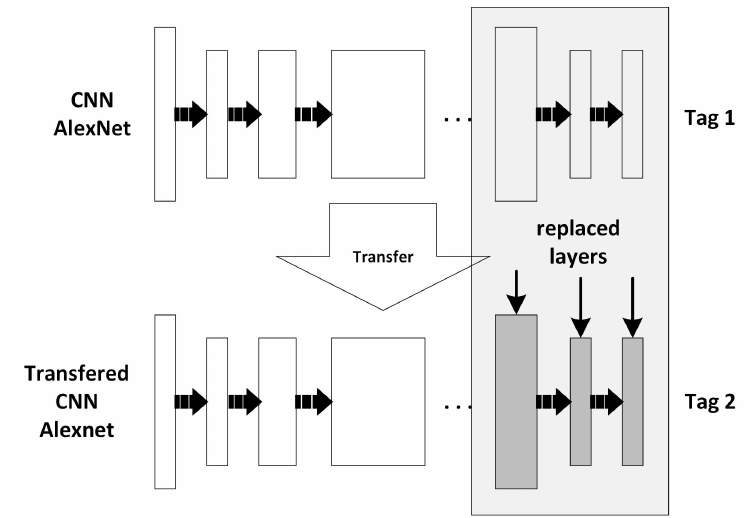
Figure 7. Learning transfer for Convolutional Neural Network (CNN) AlextNet.